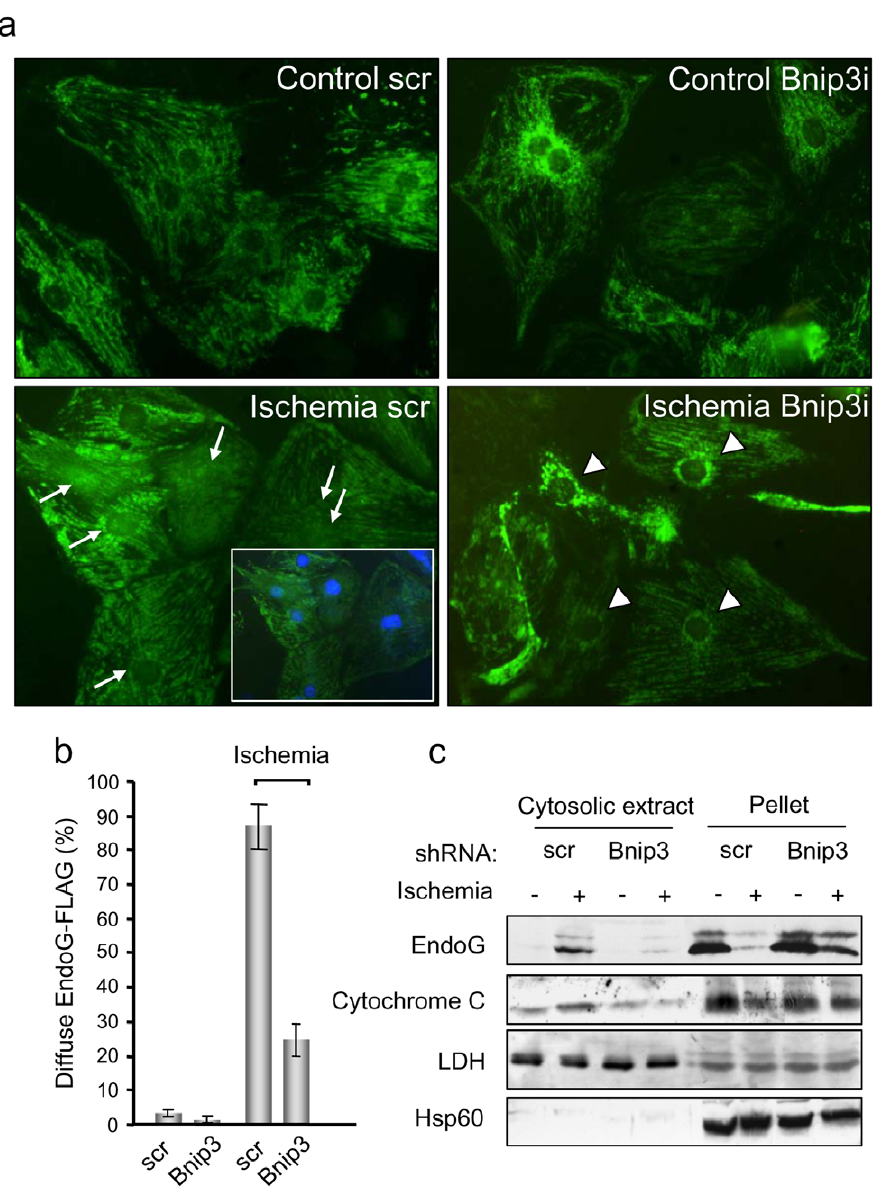
Figure 3. BNIP3 controls EndoG release from cardiac mitochondria during ischemia. a) Immunofluorescence of EndoG-FLAG in overexpressing neonatal cardiomyocytes cultured in control (control) and ischemic (ischemia) conditions for 12 hours. Bnip3i: cardiomyocytes with silenced expression of Bnip3 by shRNA. Scr: scrambled. Arrows: cardiomyocytes where EndoG-FLAG expression includes the nucleus. A merged image including Hoechst nuclear staining is included for ischemic cardiomyocytes to localize the nuclei. Arrowheads: ischemic cardiomyocytes